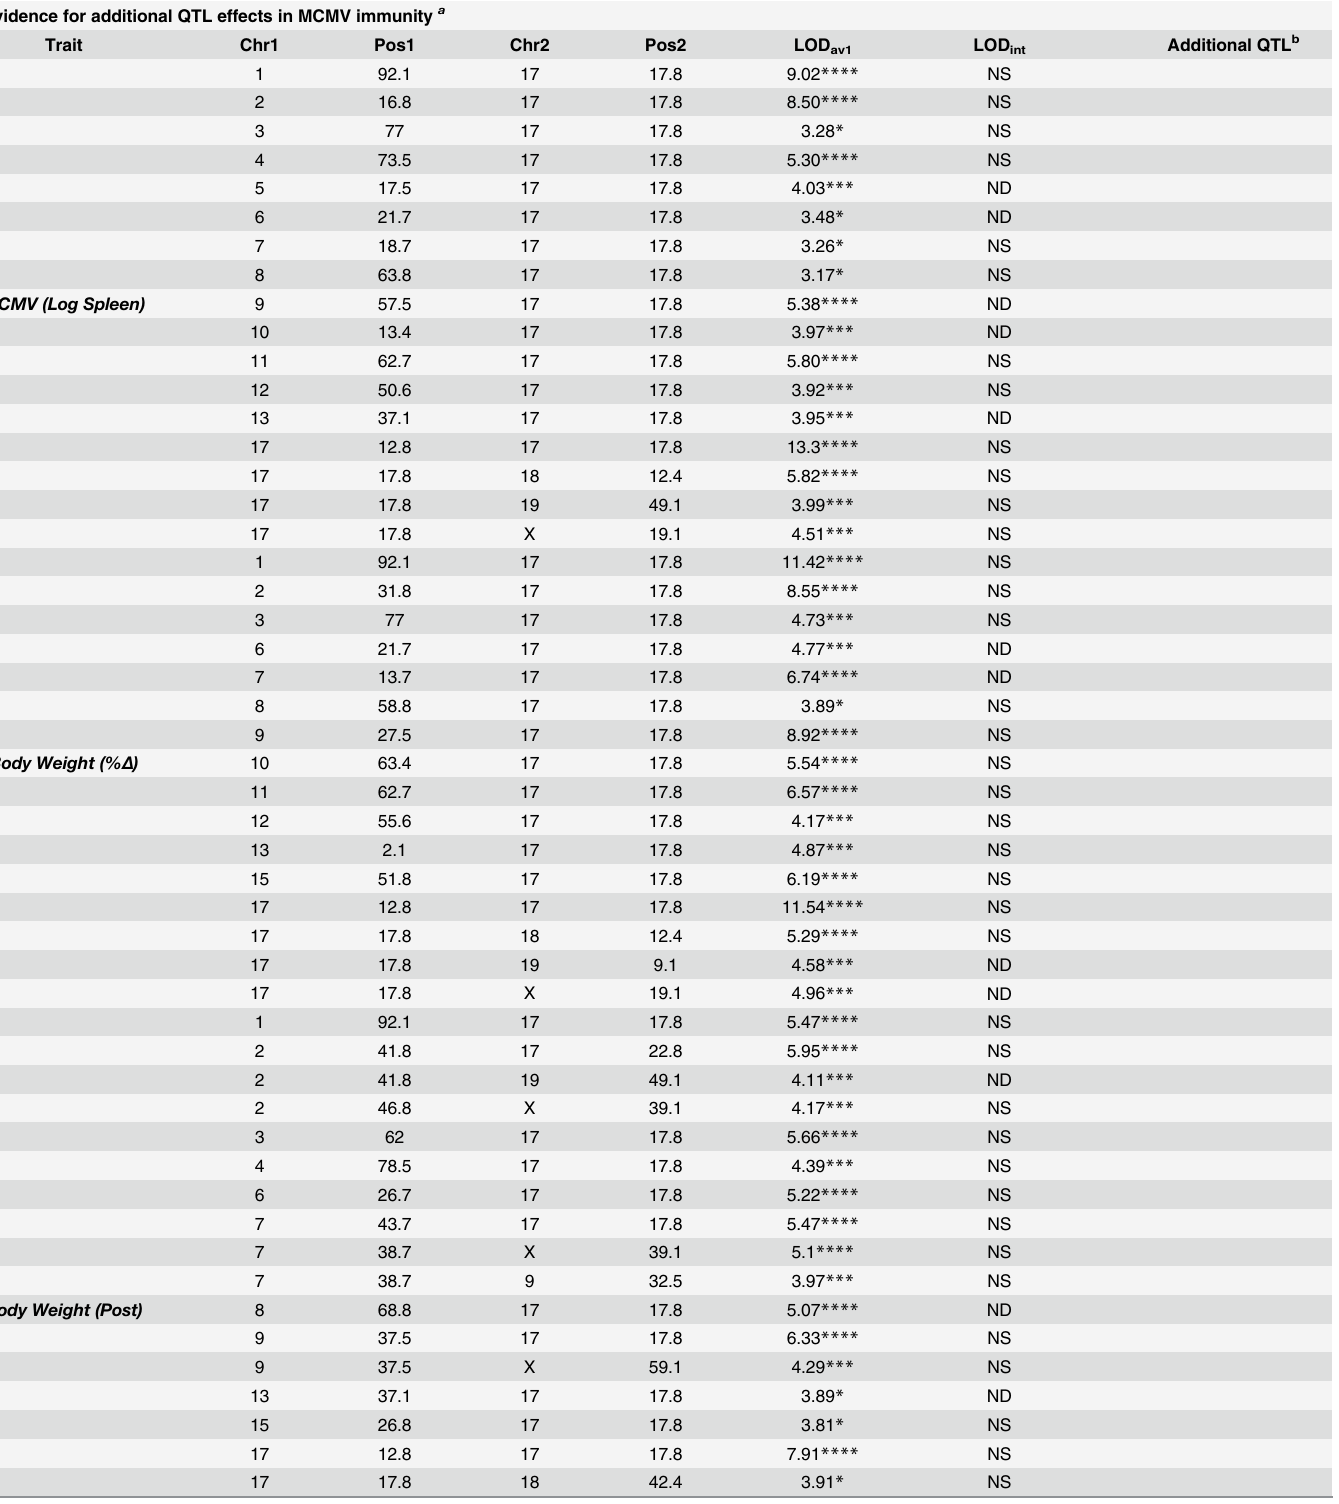
Table 2. Two-dimensional genome scan results for immune and host response traits. Evidence for additional QTL effects in MCMV immunity a Trait